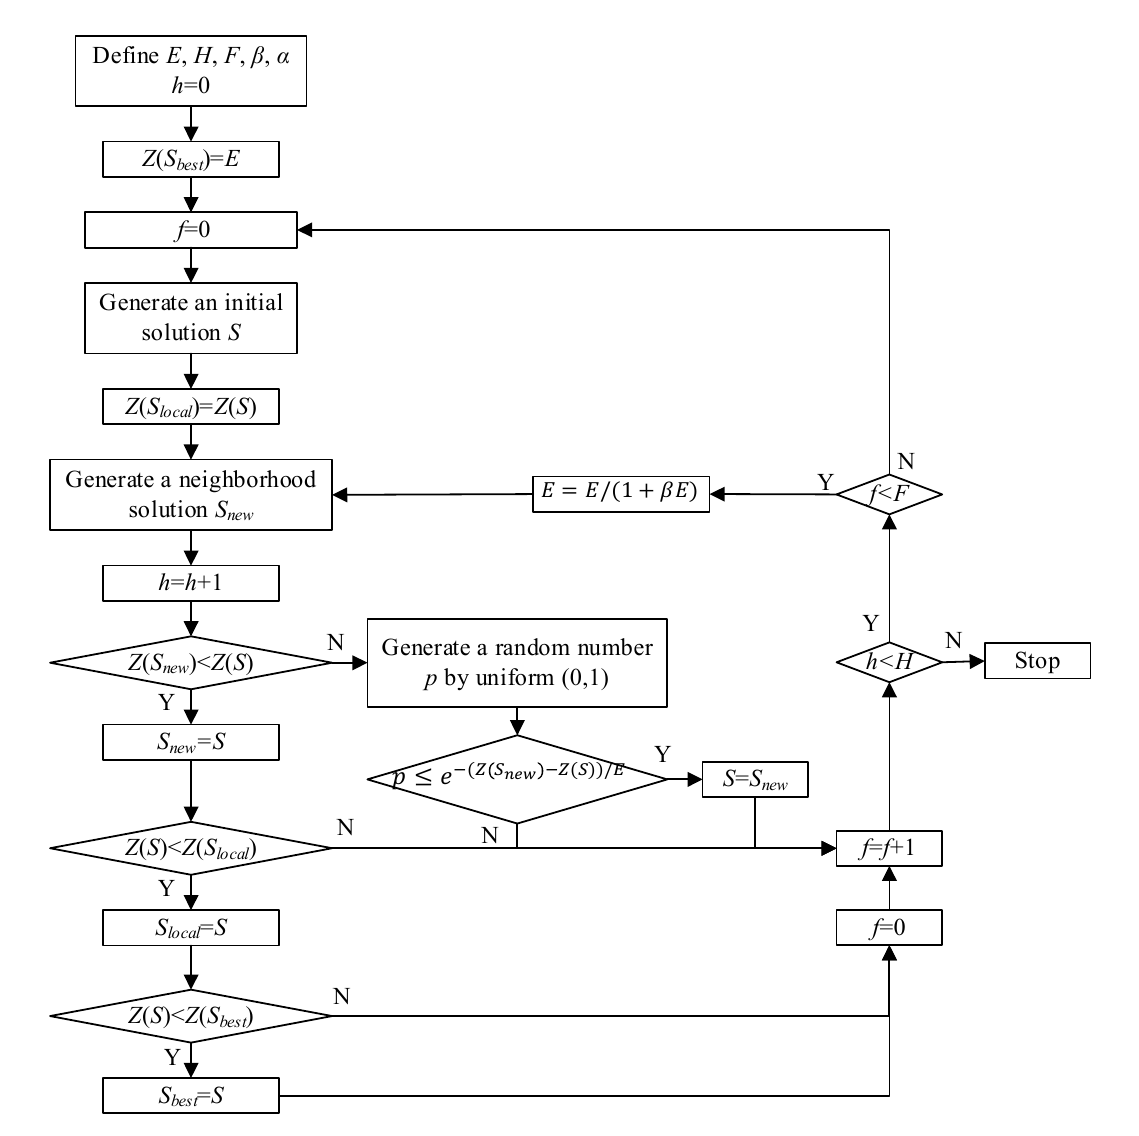
Figure 11. Proposed SA procedure.